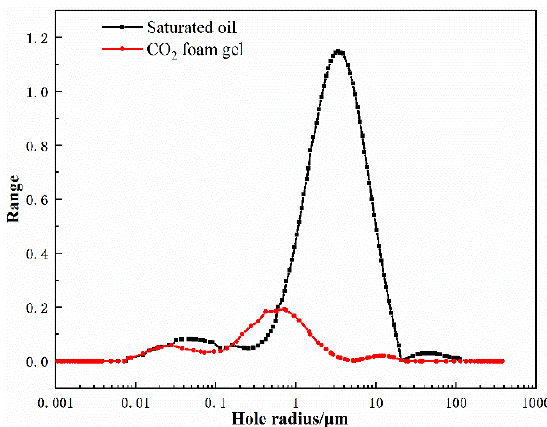
Figure 6. NMR T 2 spectra of core No.2 before and after injection of CO 2 foam gel.